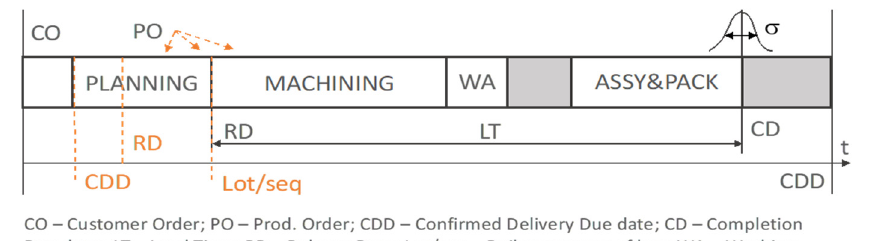
Figure 5. Phases of the order fulfillment process from order incoming to delivery.